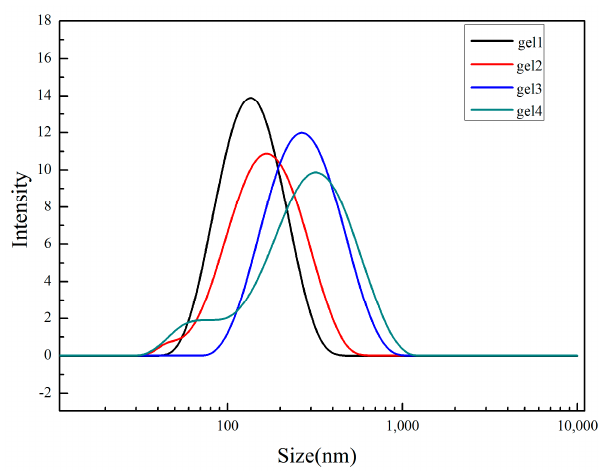
Figure 7. The particle size diagrams of nanogels at different degrees of PLA.